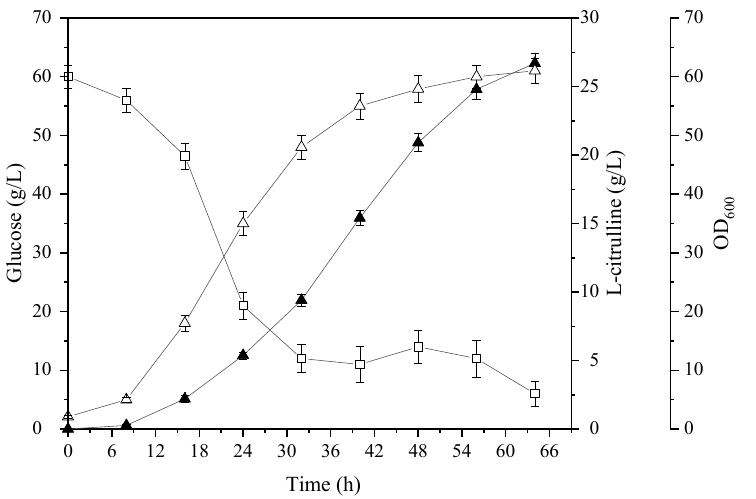
Figure 5. Fed-batch fermentation of CRBGCo strain in 5-L stirred fermenter. Signal denotes: filled triangle, L-citrulline; empty square, glucose; and empty triangle, OD 600 . The error bars represent the standard deviation of three independent replicates.